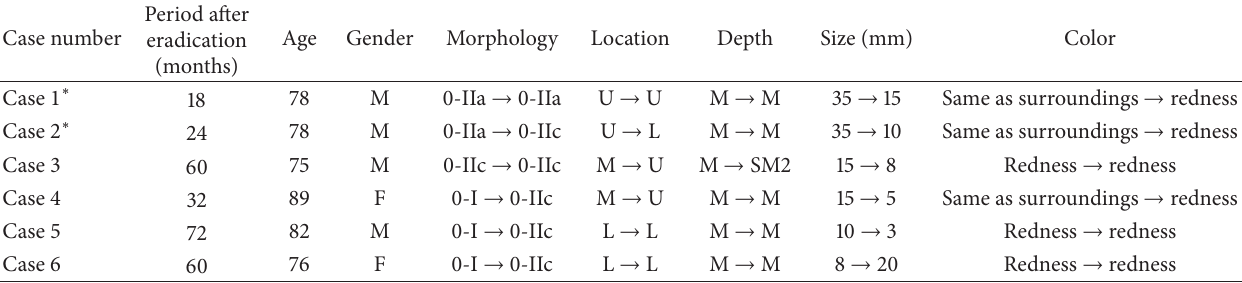
Table 2: Six metachronous cases diagnosed after initial ESD and subsequent successful eradication.